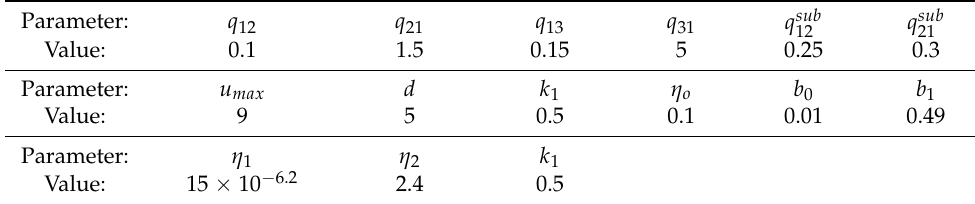
Table 2. Data for the numerical case study.